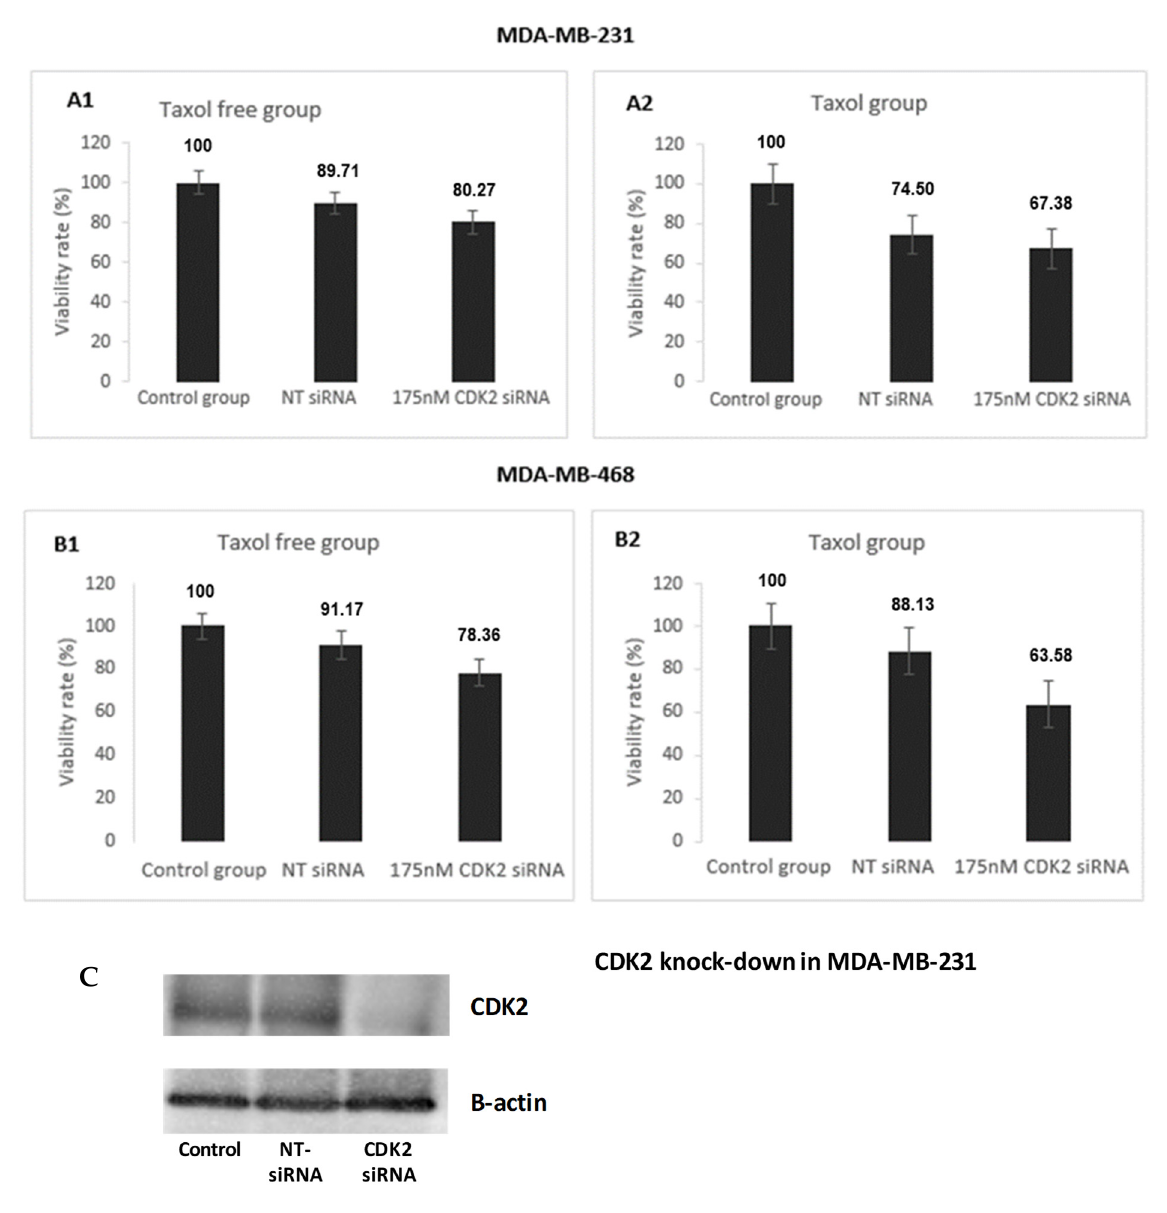
Figure 8. Effect of CDK2 knockdown on the proliferation of MDA-MB-231 and MDA-MB-468. ( A1 ) Taxol-free group in MDA-MB-231. ( A2 ) Taxol group in MDA-MB-468. ( B1 ) Taxol-free group in MDA-MB-468. ( B2 ) Taxol group in MDA-MB-468. ( C ) Confirmation that the CDK2 has been successfully knocked down in TNBC